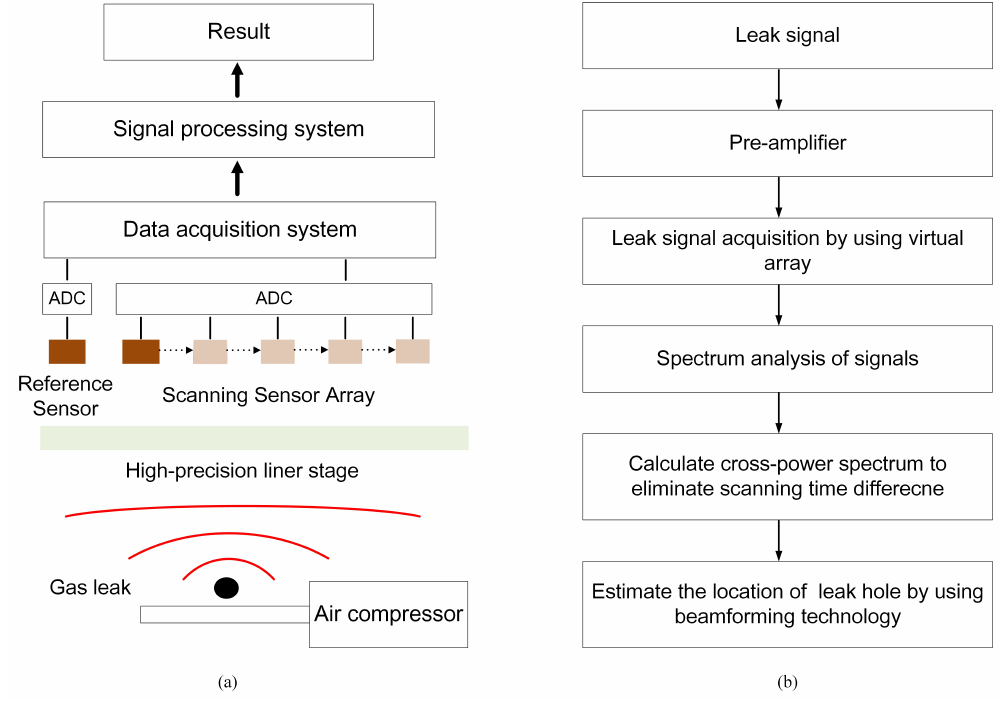
Figure 1. ( a ) Block diagram of experimental apparatus. ( b ) Flowchart for the process of estimating the location of the leak